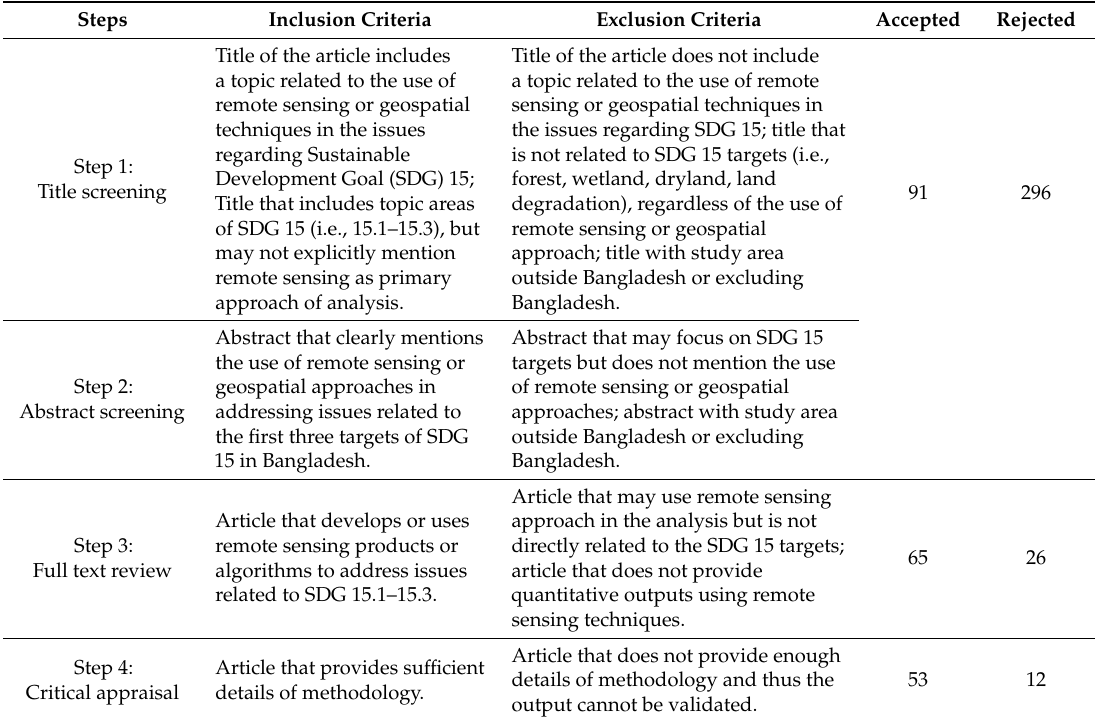
Table 1. Inclusion and exclusion